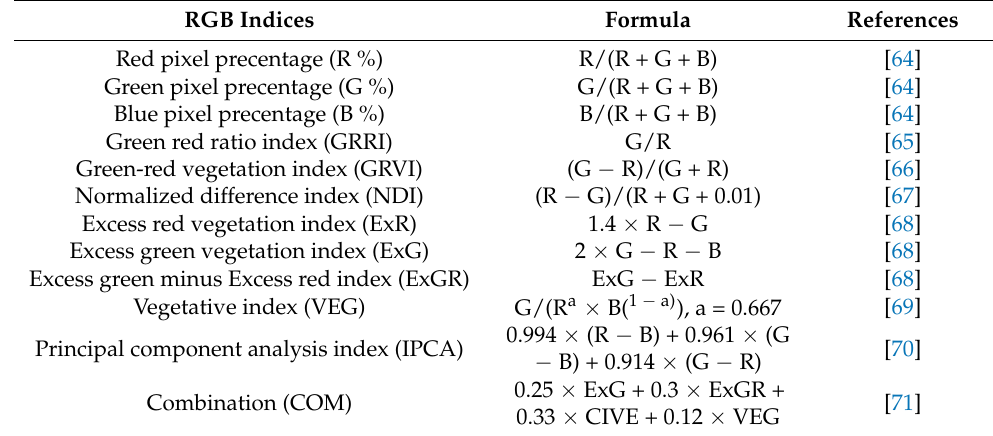
Table 1. Description of Different RGB Imagery Indices Tested in This